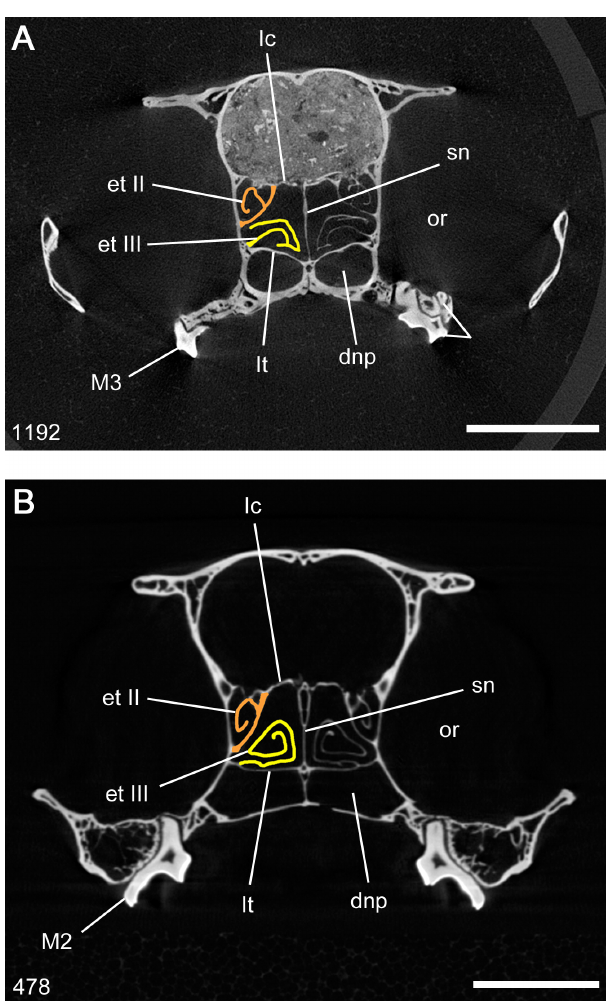
Figure 13. µCT cross-section images of the pars posterior of the adult rostrum from anterior to posterior of (a) Ptilocercus lowii (ZMB 3992) and (b) Tupaia sp. (collection W. Maier). Numbers in figures refer to number of original µCT slices. Abbreviations: dnp, ductus nasopharyngeus; et II, III, ethmoturbinal II, III; lc, lamina cribrosa; lt, lamina terminalis; M2, 3, upper molar 2, 3; or, orbit; sn, septum nasi. Scale bars equal 2mm.